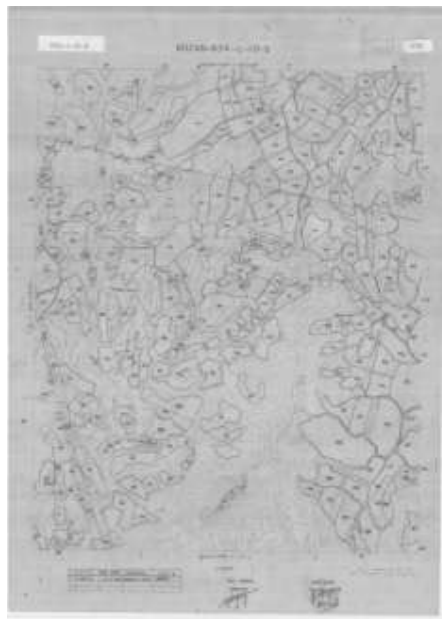
Figure 5. Photogrammetric map as an